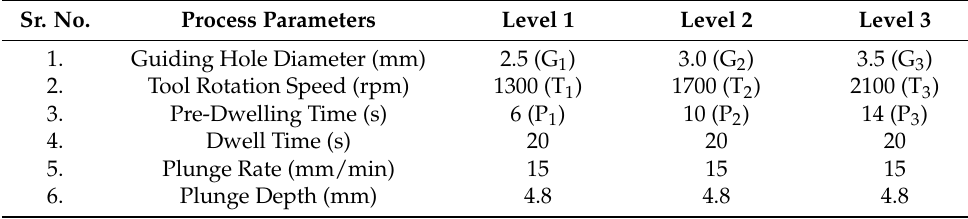
Figure 2. Test specimen configuration. Table 1. Process parameters and their levels.